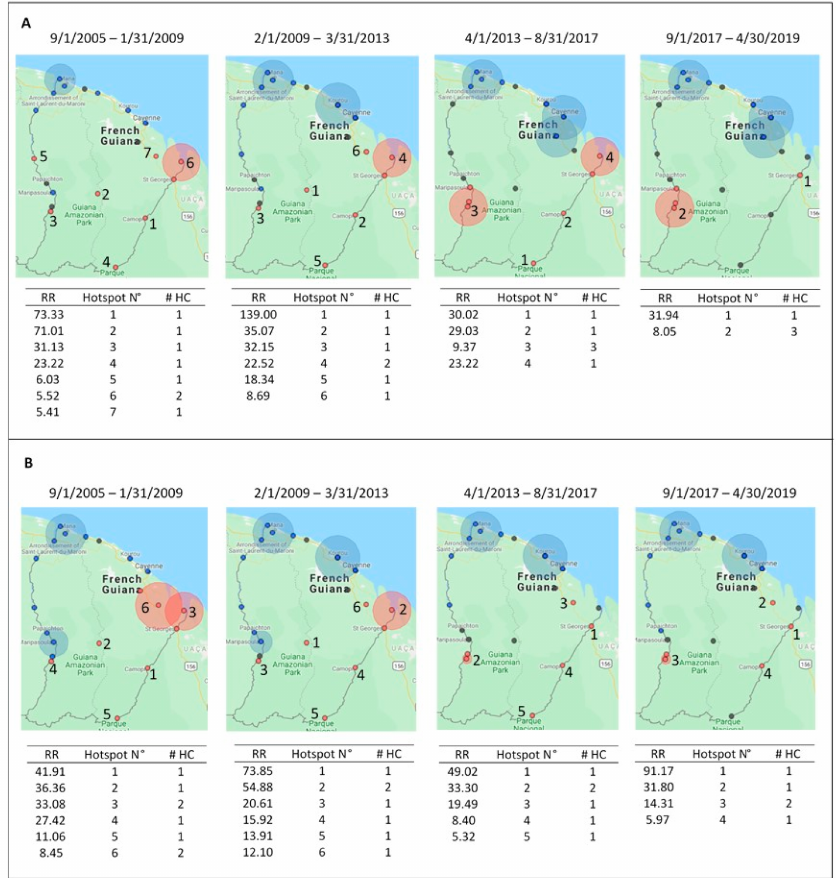
Figure 4. The red circles represent the high-risk clusters for P. falciparum ( A ) and P. vivax ( B ) during each transmission period. The blue circles indicate cold spots, and the black circles indicate neutral spots relative to the other locations. The attached tables present the risk ratios (RRs) for each hotspot along with the hotspot number (N ◦ ) corresponding to the number on the map, and the number of health centers within each cluster (#